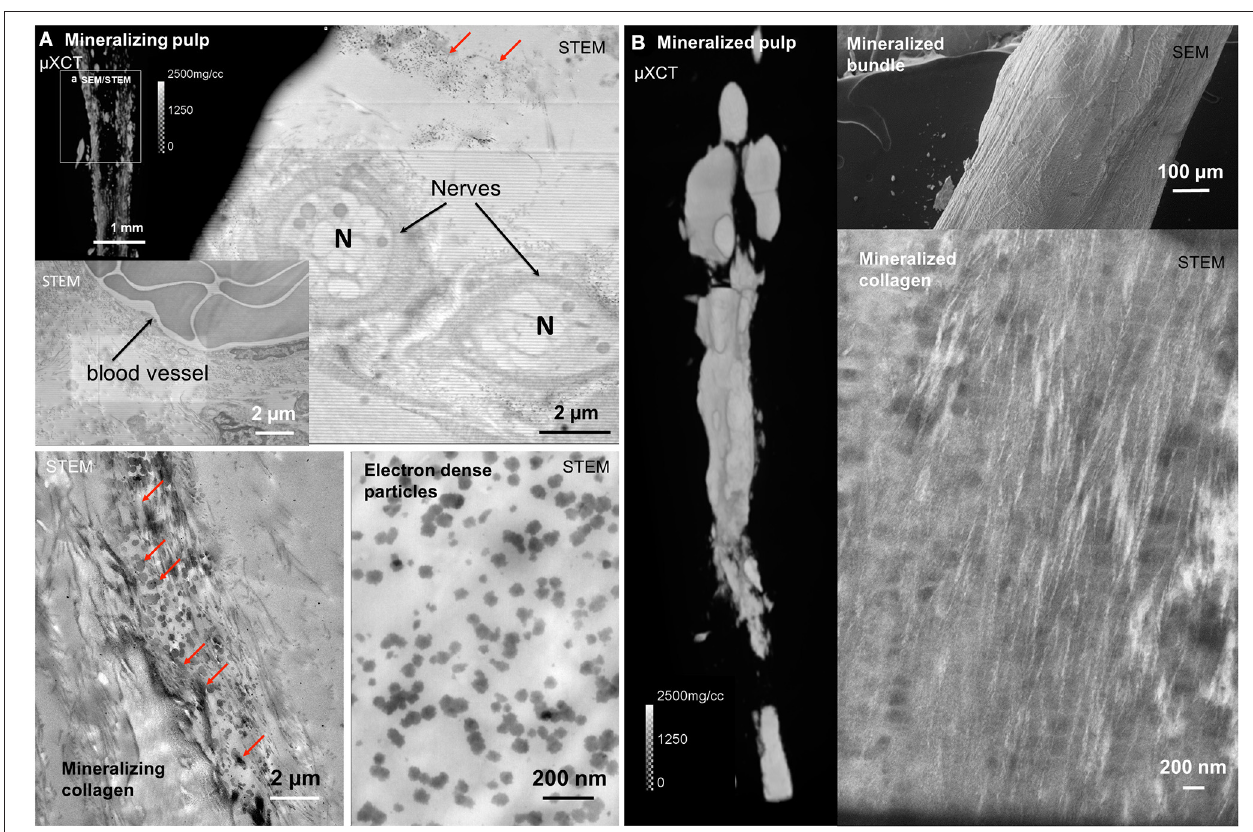
FIGURE 4 | Blood vessels, nerves, electron dense particulates, and collagen with intrafibrillar mineral are contained in partially and fully mineralized pulp. (A) Cells, blood vessels, and nerves were observed within mineralizing pulp (red arrows). (B) Dense collagen bundles with collagen fibrils and electron dense particles also were observed in macroscale mineralizing and mineralized collagenous